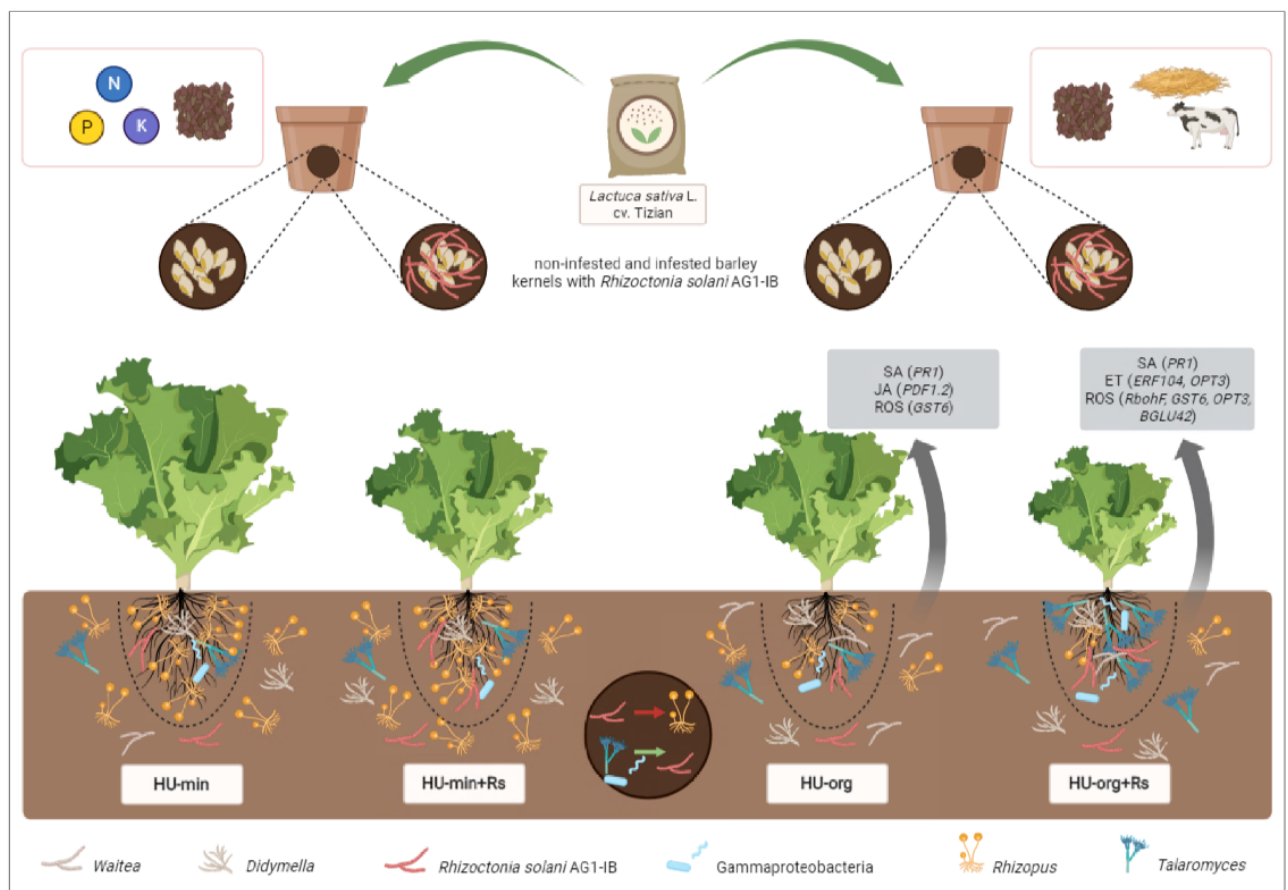
Figure 7. Graphical model summarizing the main results of fertilization strategy and the pathogen Rhizoctonia solani AG1-IB on shoot and root growth, on gene expression levels and on the most relevant microorganisms in root-associated soil (fungi, outside of the dashed lines) and in the rhizosphere (bacteria and fungi, inside of the dashed lines) of lettuce. In summary, long-term organic fertilization altered the competition of indigenous soil microorganisms and led to a better establishment of R. solani in organic-fertilized soils. In the absence of the pathogen, higher relative abundances of Rhizoctonia -like structures ( Waitea ) and putative pathotrophs ( Didymella ) in organic-fertilized soils likely resulted in increased gene expression (defense-priming). In the presence of the pathogen in organic-fertilized soils, plant-beneficial microbial taxa ( Talaromyces , Gammaproteobacteria) were significantly enriched (green arrow) and genes that are part of defense mechanisms in a systemic response were more upregulated, resulting in reduced lettuce growth. In general, the genus Rhizopus was more abundant in mineral-fertilized soils and less abundant in organic-fertilized soils due to the mycoparasitism of R. solani (red arrow). Figure was created with BioRender.